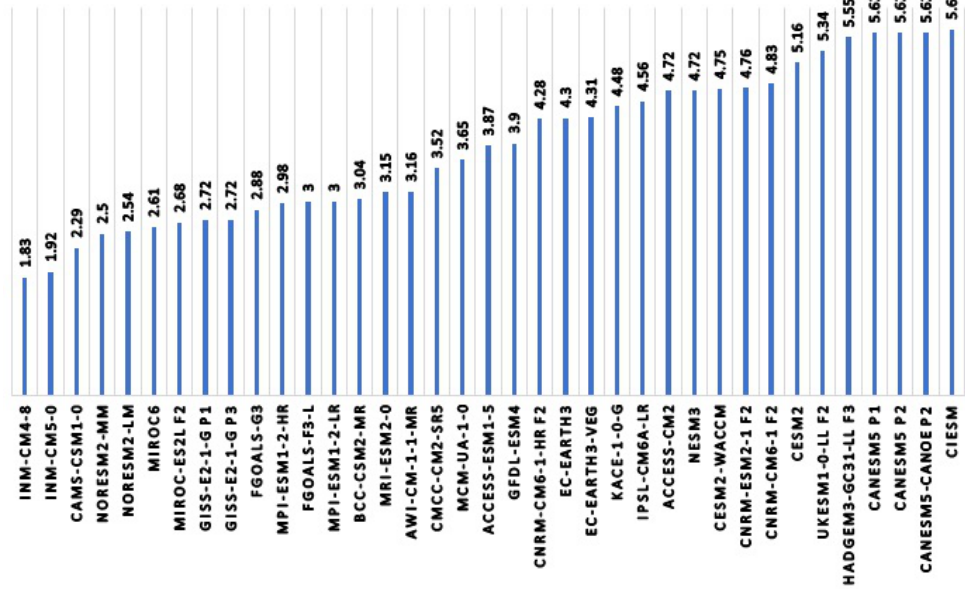
Figure 1. Equilibrium climate sensitivity of 42 CMIP6 GCMs. (From Table 7.SM.5 in Ref.